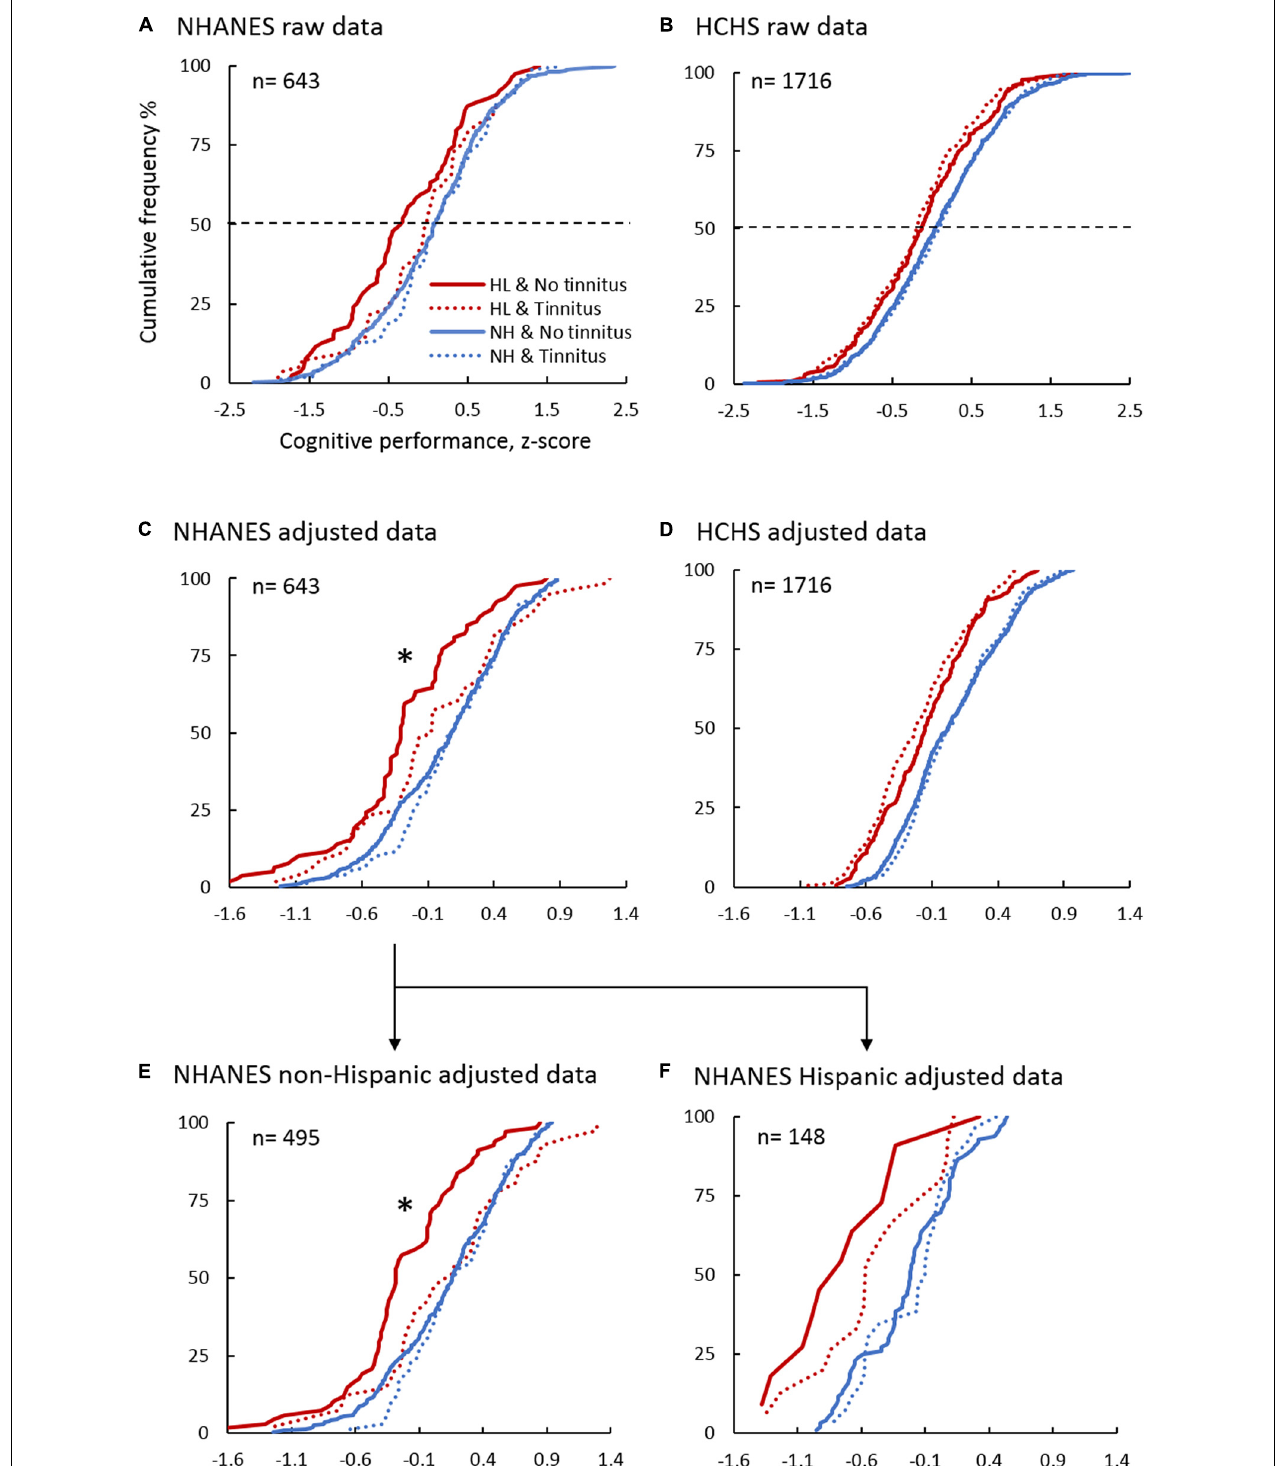
FIGURE 2 | Cumulative Frequency Distribution of the Cognitive Performance Z-score in the NHANES and HCHS Sub-cohorts. Panels show the raw data in NHANES (A) and HCHS (B) , the adjusted cognitive performance using multivariable linear regression in NHANES (C) , HCHS (D) , NHANES non-Hispanic (E) , and NHANES Hispanic (F) sub-cohorts. Blue lines denote normal hearing, and red lines are of hearing loss. Solid lines are of No tinnitus, and dashed lines are of tinnitus. ∗ indicates a significant association between tinnitus and improved cognition in the hearing loss sub-cohort ( p < 0.05).